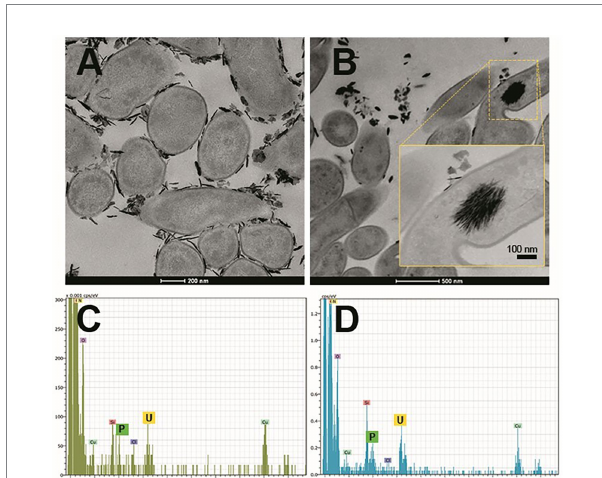
FIGURE 9 Scanning transmission electron microscopy (STEM) micrographs of thin sections of Amycolatopsis ruanii /bacterial consortium ( Bradyrhizobium - Rhizobium and Pseudomonas ) cells treated with uranium (A) , and uranium + glycerol-2-phosphate (B) . Extracellular and intracellular precipitates of uranium phosphates and their corresponding EDX spectra with peaks of U and P (C,D) respectively. Personal archive of Dr. Merroun; growth conditions detailed in Povedano-Priego et al.